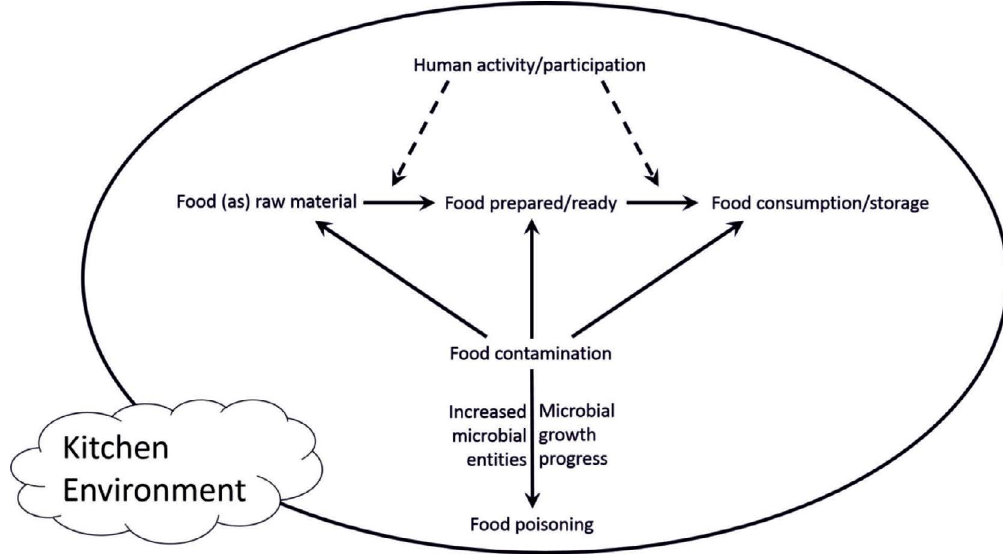
Fig. 1. Human activity/participation during food (as) raw material, preparation, and consumption/stages adding food contamination that can progress onto poisoning, all within the kitchen